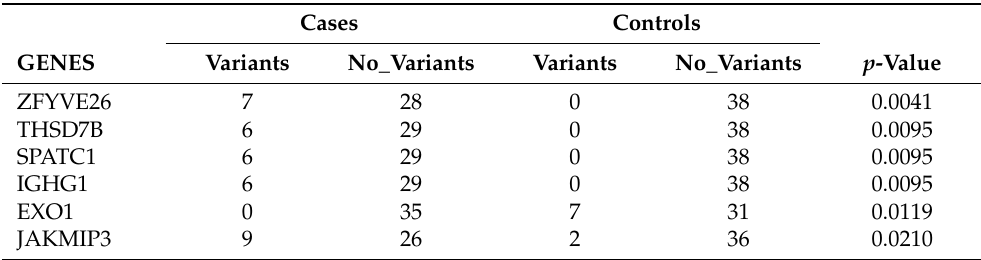
Table 2. Genes obtaining nominal p -value < 0.05 in